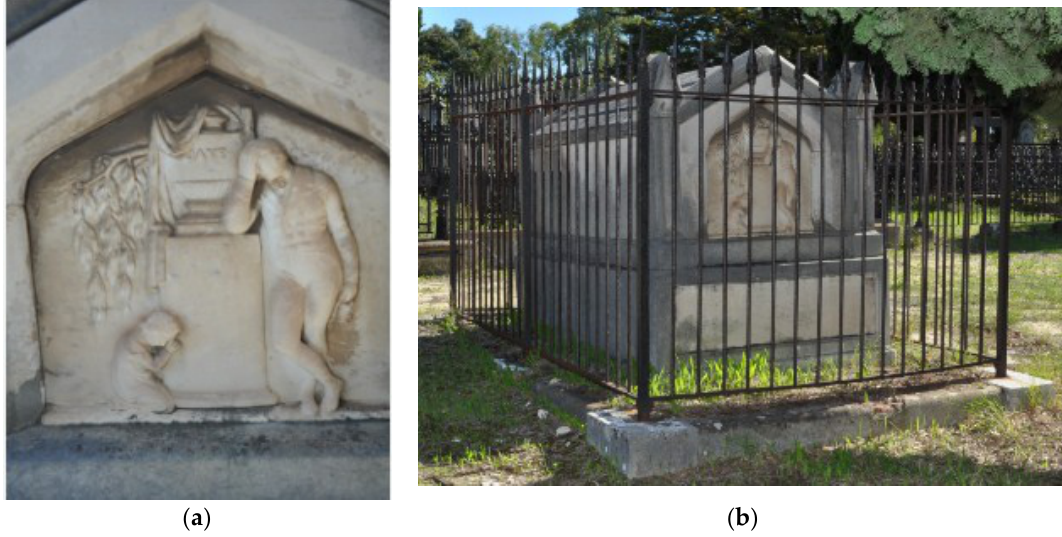
Figure 3. Jane Pearson monument, National Trust #423: ( a ) Captain James Pearce is depicted with his daughter Janet weeping at the grave of his wife Jane. Note the willow branch to the left of the urn; ( b ) the chest tomb. Photographs are by Colin Strickland, and were provided courtesy of the East Perth Cemeteries website.